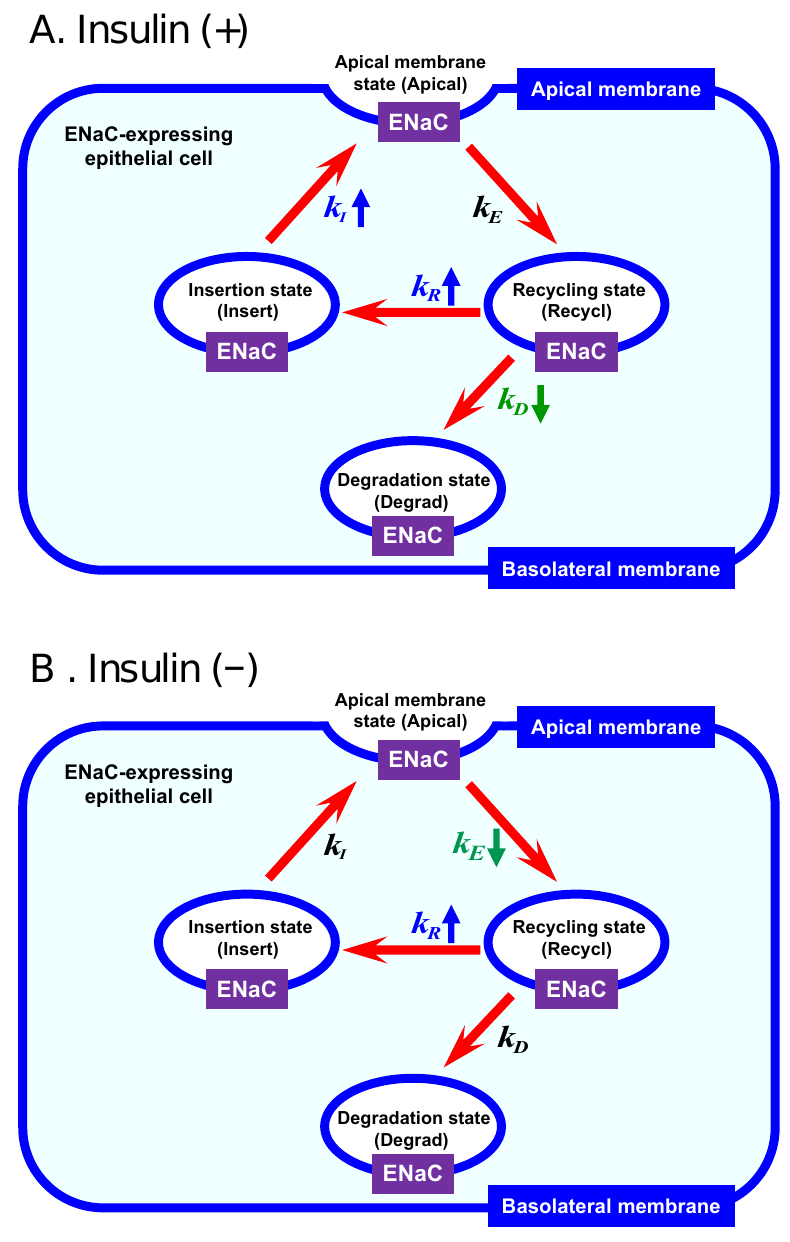
Figure 4. The action of aldosterone treatment (1 µM, 20 h) on the intracellular ENaC trafficking under the condition with ( A ) and without ( B ) stimulation by insulin (100 nM). ( A ) Under the insulin-stimulated condition, aldosterone treatment significantly elevated 𝑘 𝐼 3.3-fold and 𝑘 𝑅 2.0-fold, but diminished 𝑘 𝐷 0.7-fold without any significant effect on 𝑘 𝐸 . ( B ) Under the insulin-unstimulated condition, aldosterone treatment significantly decreased 𝑘 𝐸 0.5-fold and increased 𝑘 𝑅 1.4-fold without any significant effect on 𝑘 𝐼 or 𝑘 𝐷 .